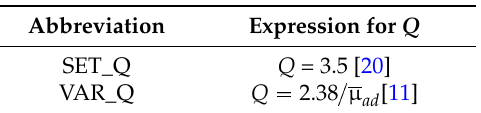
Figure 3. Separation of data for algorithm parameterization, validation, and partitioning of error. Table 2. Abbreviations used for evaluation of best-performing Q .